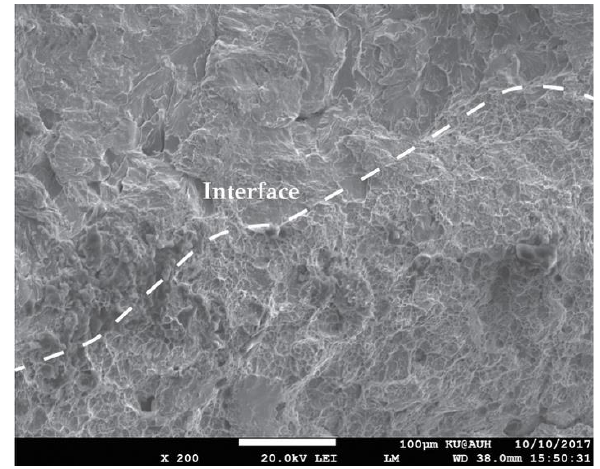
Figure 11. Boundary between SOHIC and “fresh” fracture .